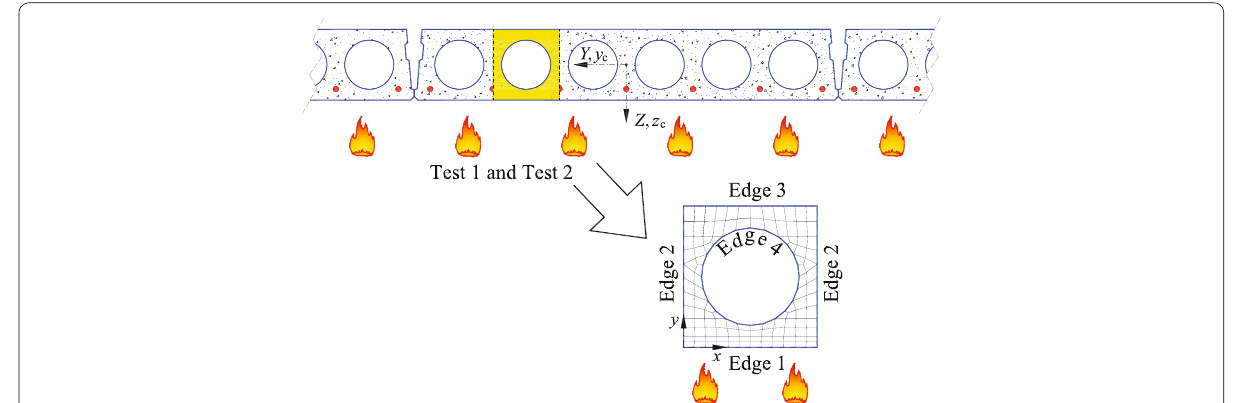
Fig. 6 The HC slab cross-section geometry and finite element mesh to determine the distribution of